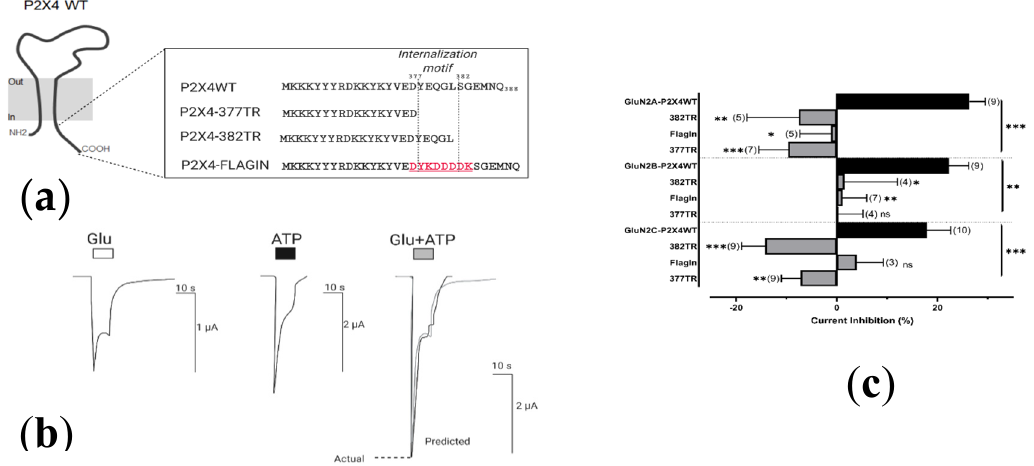
Figure 6. Residues in the P2X4 CT confer the ability to interact with NMDARs. ( a ) An illustration of the mutations performed on the P2X4 internalization motif, compared to the wildtype P2X4 (P2X4WT); ( b ) Representative currents recorded in Ringers’ solution from an individual oocyte coexpressing P2X4-377TR and GluN2A-containing NMDARs responding to: Glu (2 µ M), ATP (1 µ M), or Glu and ATP (2 µ M and 1 µ M, respectively). The predicted additive response (grey line) is calculated as the sum of the individual Glu and ATP induced currents. ( c ) Bar graphs representing the current inhibition obtained from coapplication of Glu and ATP for oocytes coexpressing different P2X4 mutants and